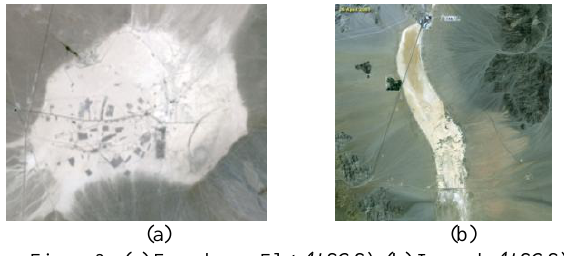
Figure 3. (a) Frenchman Flat (USGS); (b) Ivanpah (USGS)